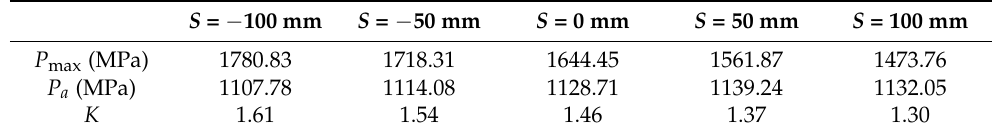
Roll Shifting Position (mm) Figure 8. F2 stand work roll shifting position distribution.